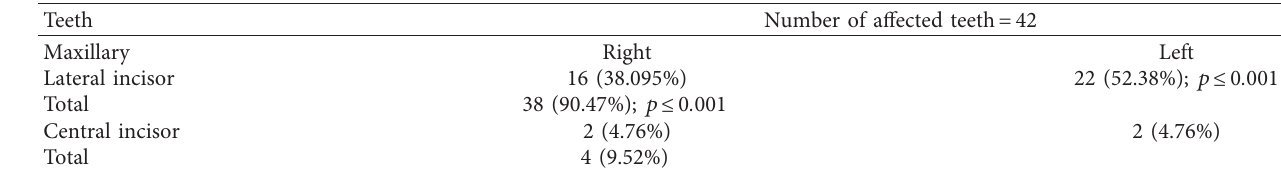
Table 3: Distribution of dens invaginatus according to